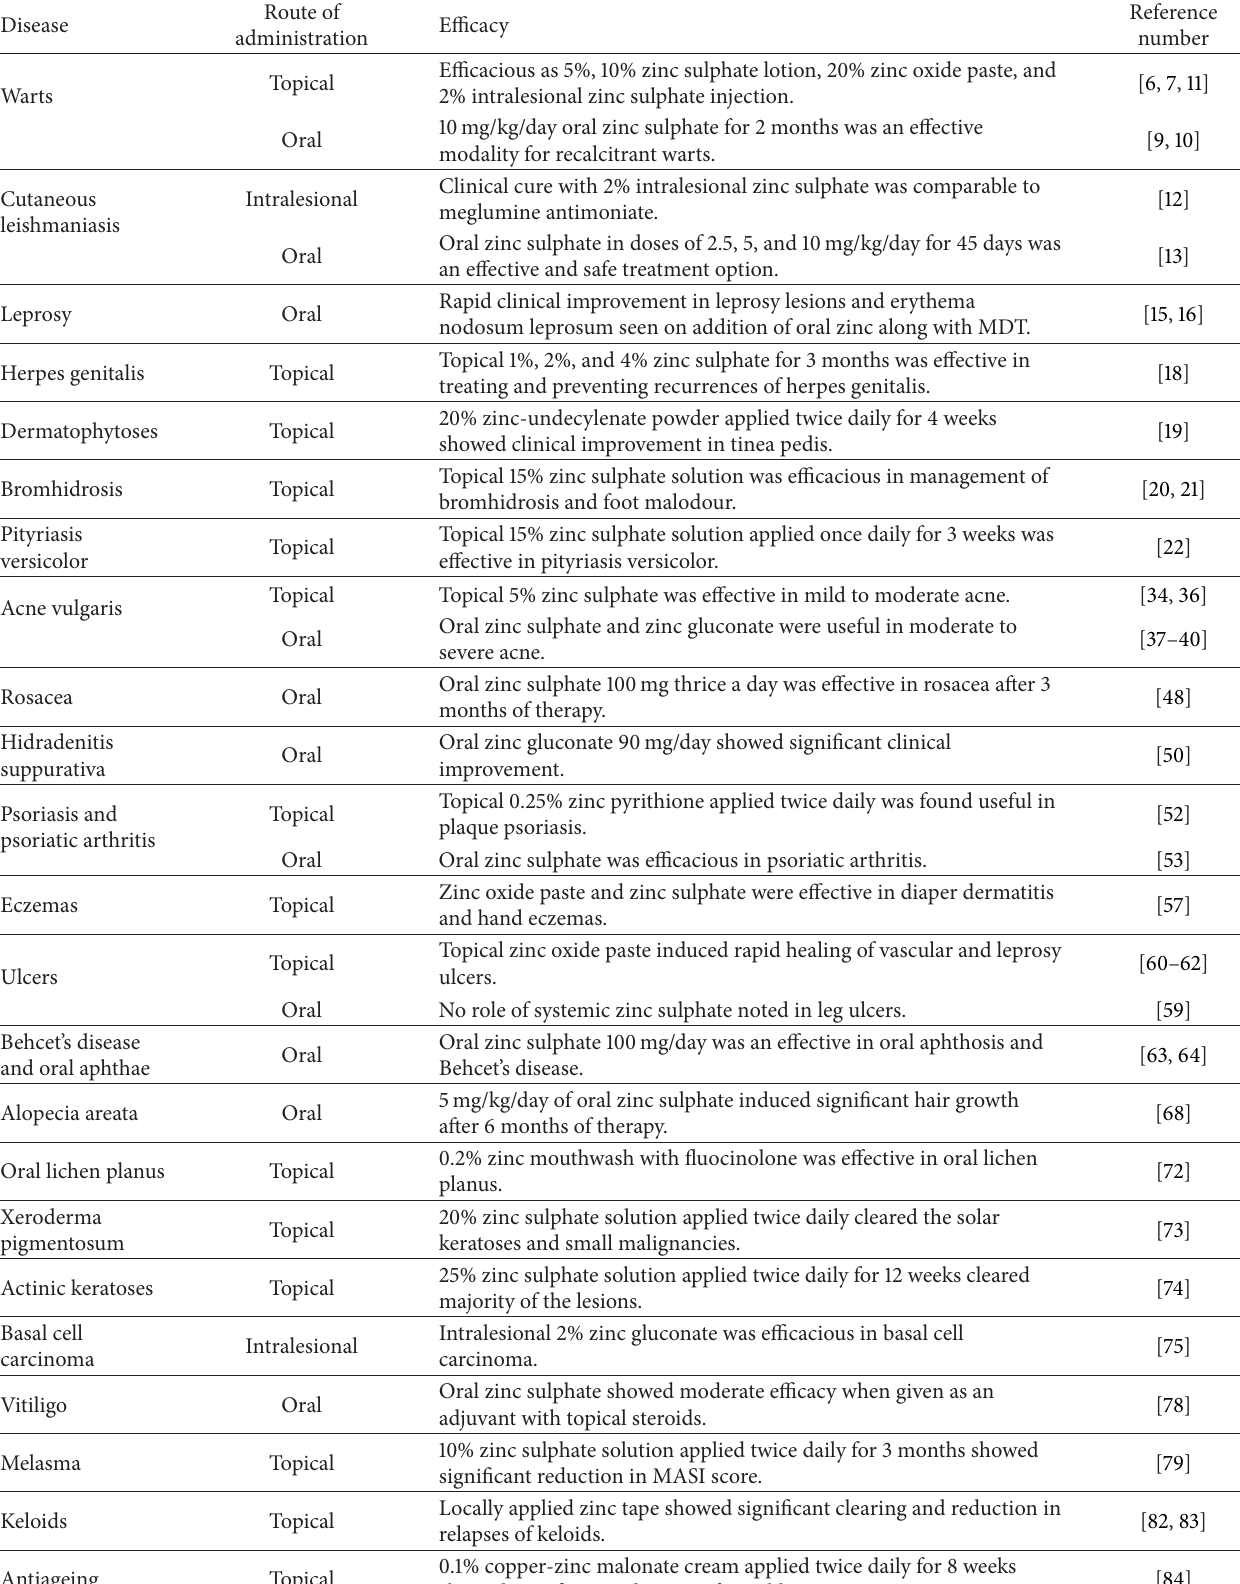
Table 1: Therapeutic uses of systemic and topical